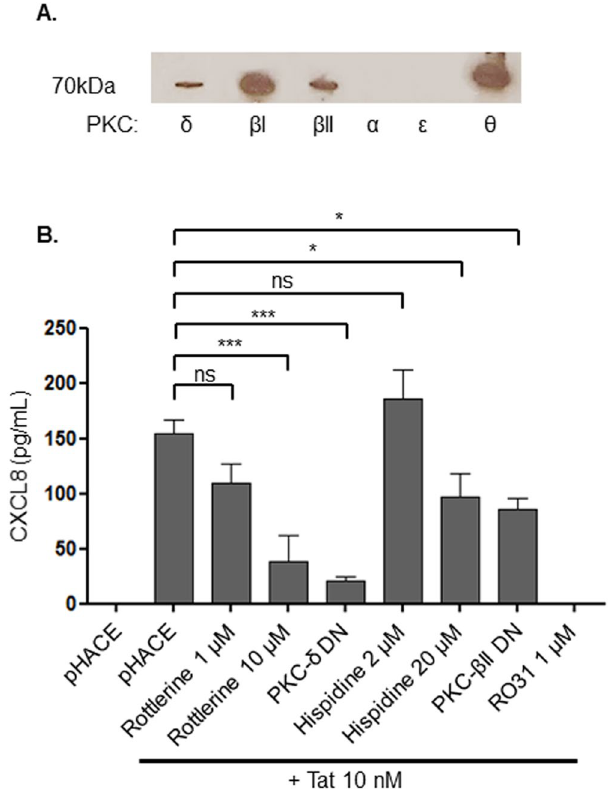
Figure 2. PKC- δ is essential for Tat-induced CXCL8 production. ( A ) HEK cells (10 7 cells) were lysed and then equal amounts of protein (20 μ g) were analysed by SDS-PAGE and western blot by using antibodies specific for each isoform of PKC. These results are representative from three independent experiments. ( B ) HEK-TLR4 cell lines (10 6 /well) were transfected with 0.5 µ g of the empty vector pHACE, or vector encoding for PKC- β II DN or PKC- δ DN for 24 h or incubated for 60 min with RO-31 8220, a total PKC inhibitor, Rottlerin, a PKC- δ inhibitor or Hispidin a PKC- β II inhibitor before cells were treatment with HIV-1 Tat (10 nM). All chemical inhibitors were previously tested, by the trypan blue dye exclusion assay for the absence of cytotoxic effect at the concentration used (data not shown). After 24 hours of incubation, cell supernatant was collected and CXCL8 production was quantified by ELISA. The data represent means and standard deviation (SD) of three independent experiments. Statistical significance comparing different group were analysed with one-way ANOVA followed with a Bonferroni post tests and are denoted with * for p < 0.05, *** p < 0.001, ns non- significant. All bars are compared to pHACE transfected